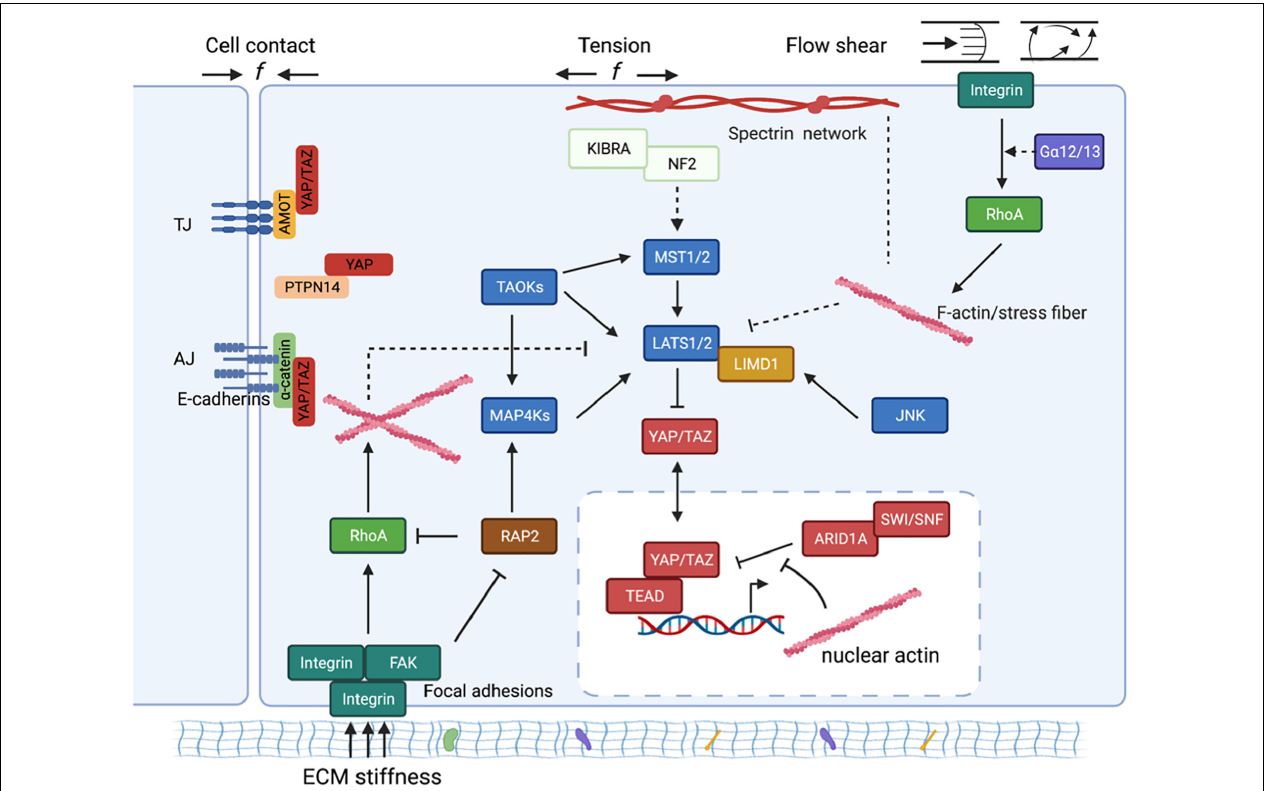
FIGURE 2 | The schematic diagram of molecular mechanisms by which mechanical cues regulate YAP/TAZ. Mechanical cues, such as cell-cell contact, ECM stiffness, externally applied mechanical stretch, and flow shear, control YAP/TAZ activity through both Hippo-dependent and -independent pathways. The core kinase cascade consisting of MST1/2 and LATS1/2, as well as novel Hippo kinases such as MAP4Ks, respond to the mechanical cues to modulate phosphorylation and localization of YAP/TAZ. Mechanical cues can also bypass these kinases and act through both cytoplasmic and nuclear actins to modulate YAP/TAZ localization. (1) In response to cell-cell contact, AMOT directly binds to YAP and thus sequesters YAP at tight junctions regardless of YAP phosphorylation status. AMOT can simultaneously act through NF2/Merlin to activate the MST1/2-LATS1/2 kinase cascade to induce phosphorylation and inactivation of YAP. Adherens junction (AJ) protein E-cadherin, upon cell confluence, trans -dimerize and subsequently inactivate YAP/TAZ through the MST1/2-LATS1/2 kinase cascade. Cell-cell contact inhibition also promotes direct interaction between PTPN14 and YAP, and thus leads to cytoplasmic translocation of YAP. (2) ECM stiffness sensed by focal adhesion promotes actin polymerization and stress fiber formation. The Hippo kinase cascade is inactivated by actin polymerization and stress fiber formation at high ECM stiffness. On the other hand, polymerized nuclear actin, under high ECM stiffness, binds to ARID1A-SWI/SNF complex, subsequently relieving its sequestration of YAP/TAZ. In addition, the stiffness-regulated GTPase RAP2 directly activates MAP4K4/6/7 as well as inhibits Rho GTPases, leading to LATS kinase activation and YAP/TAZ inhibition. Stiffness-activated JNK can phosphorylate LIMD1, which directly binds to LATS1/2 and reduces their kinases activities, thus activating YAP/TAZ. (3) Mechanical stretch or tension also acts through actin cytoskeleton to modulate YAP/TZ activities. Spectrin, a cytoskeletal protein, serves as a key linker that connects the cellular tension-sensing system to the Hippo regulation network. (4) Flow shear patterns and speeds differentially regulate activity of the Hippo kinase cascade in endothelial cells via an integrin–G α 12/13–RhoA